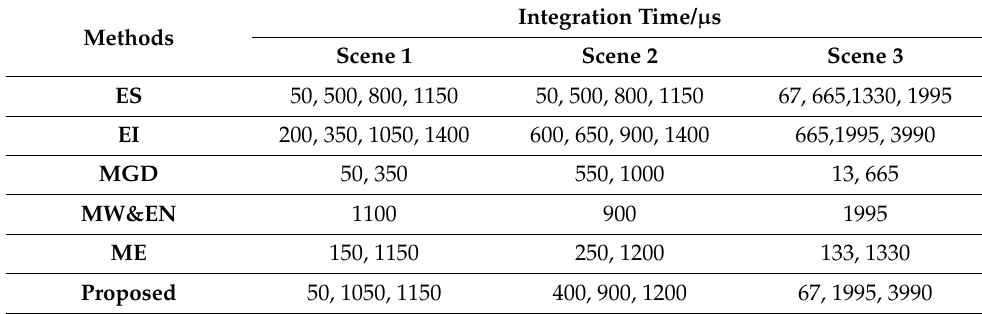
Table 2. Integration times selected for the five methods in the three scenes.